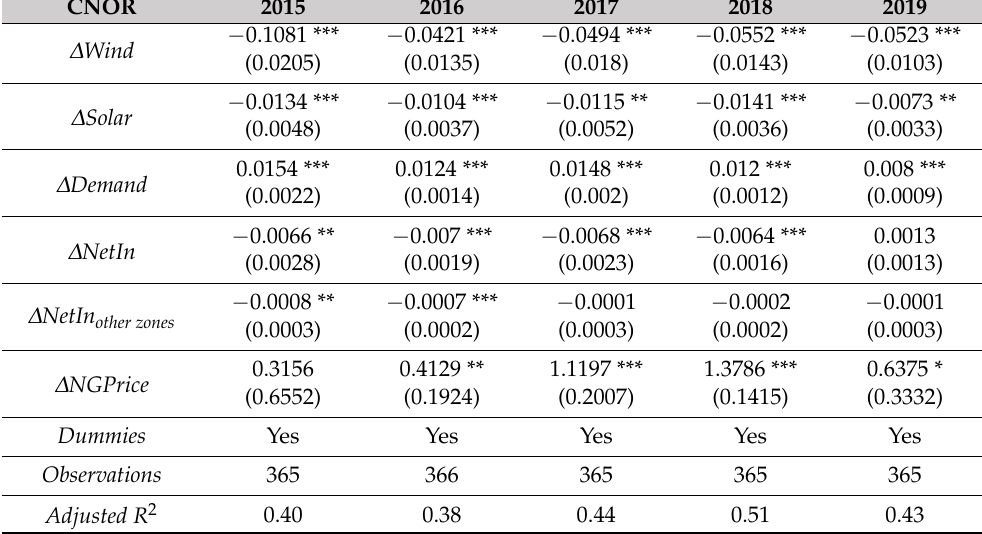
Table A13. OLS estimation of daily changes in electricity prices of CNOR; results of Equation (3).